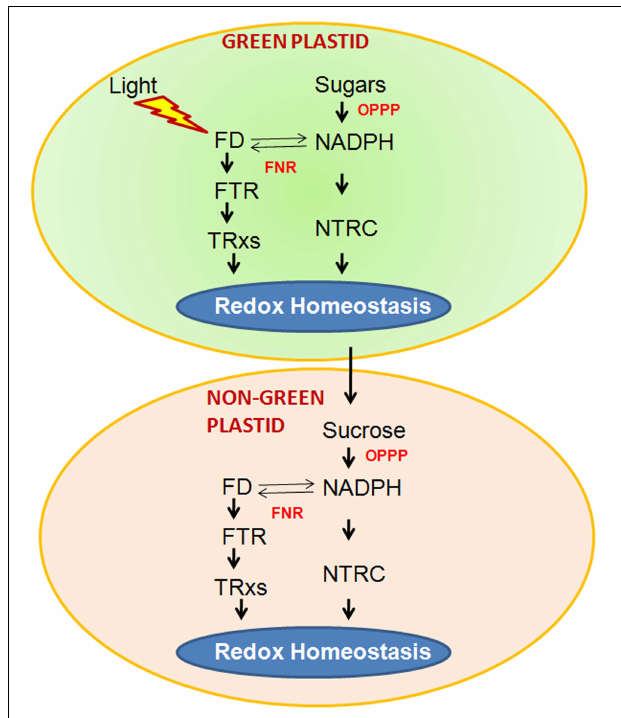
FIGURE 3 | Two operational pathways in chloroplasts of photosynthetic tissues to maintain redox homeostasis. The FTR (ferredoxin-dependent thioredoxinreductase)/TRx (thioredoxin) pathway, which relies directly on light, and the NTRC (NADPH-dependent thioredoxinreductase) pathway, which uses NADPH produced either from sugars by the oxidative pentose phosphate pathway (OPPP), or from FD (ferredoxin)/FNR (ferredoxin-NADP oxidoreductase). Both pathways may be complementary because FNR activity allows interchange of reduced FD and NADPH. In plastids of non-photosynthetic tissues the Ftr/trx and NTRC pathways are also present but the only source of reducing power is NADPH produced by the OPPP. The metabolism of both types of plastids is interconnected by nutrients, such as sucrose, produced by photosynthesis in green